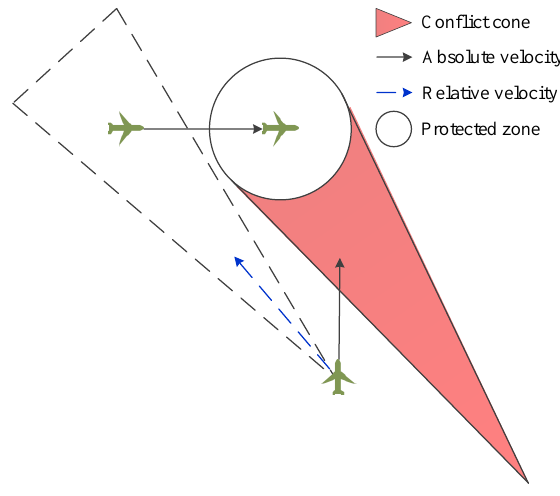
Figure 6. SSD for conflict